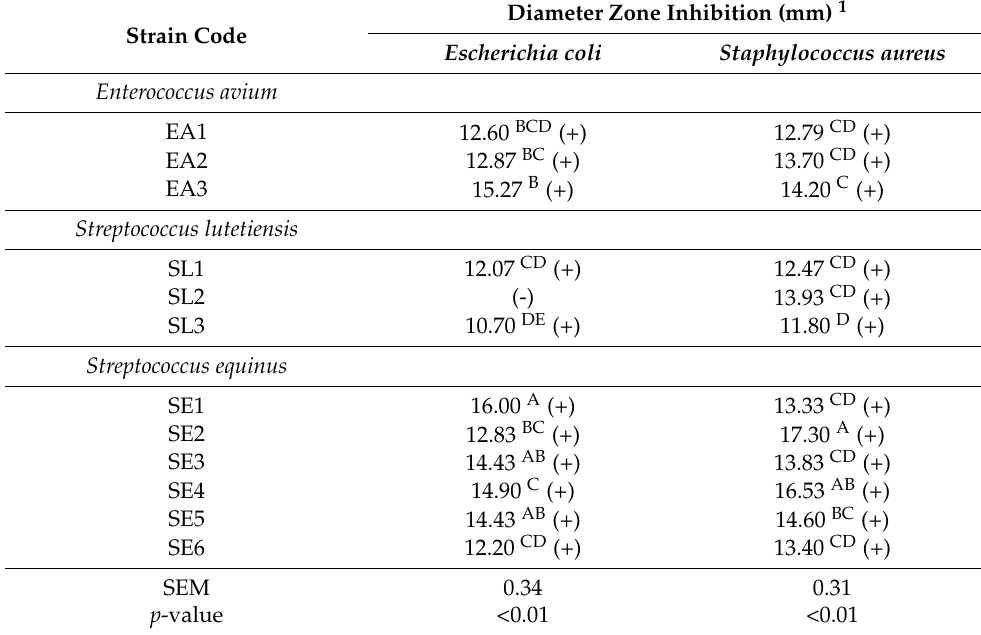
Table 4. Escherichia coli and Staphylococcus aureus zones of inhibition by supernatants from Enterococcus avium , Streptococcus lutetiensis and Streptococcus equinus